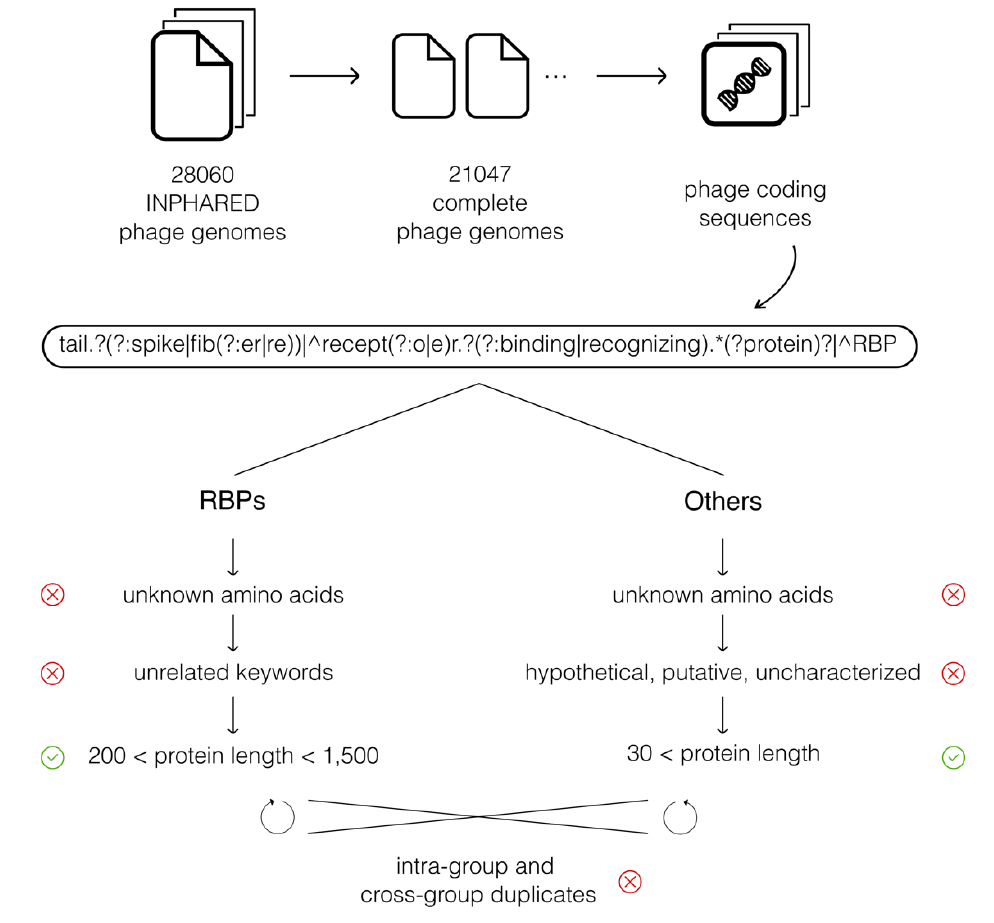
Figure 1. A schematic overview of data processing steps. Collected phage genomes from INPHARED were processed and coding sequences were extracted from each genome. Coding sequences were divided into two groups based on a regular expression that covered the various annotations of RBPs. Both groups were further processed to exclude sequences that had unknown amino acids, unwanted keywords, or extreme lengths.